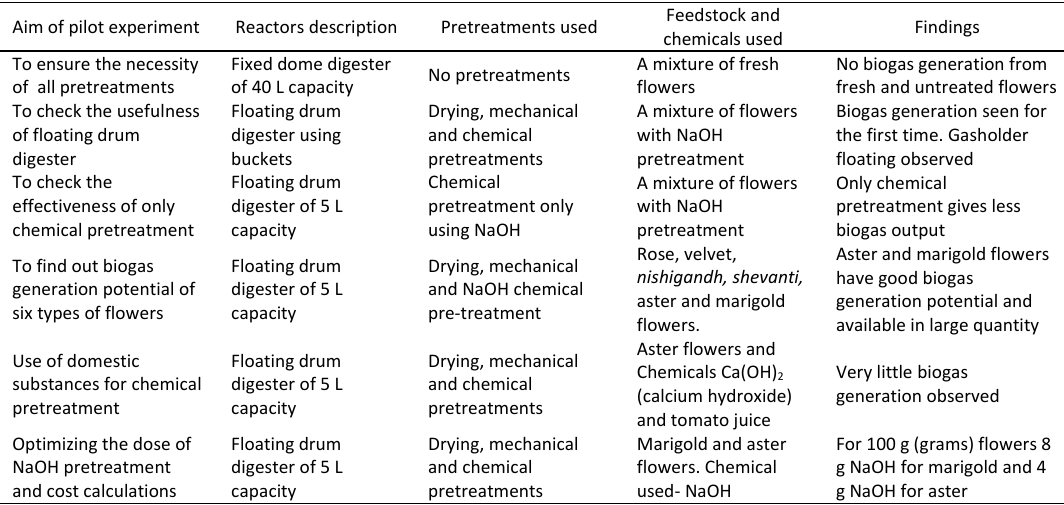
Table 1: Details of the pilot experiments performed and their outcomes